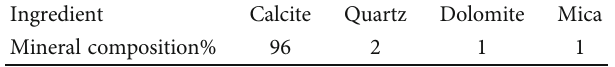
Table 1: Limestone mineral content.